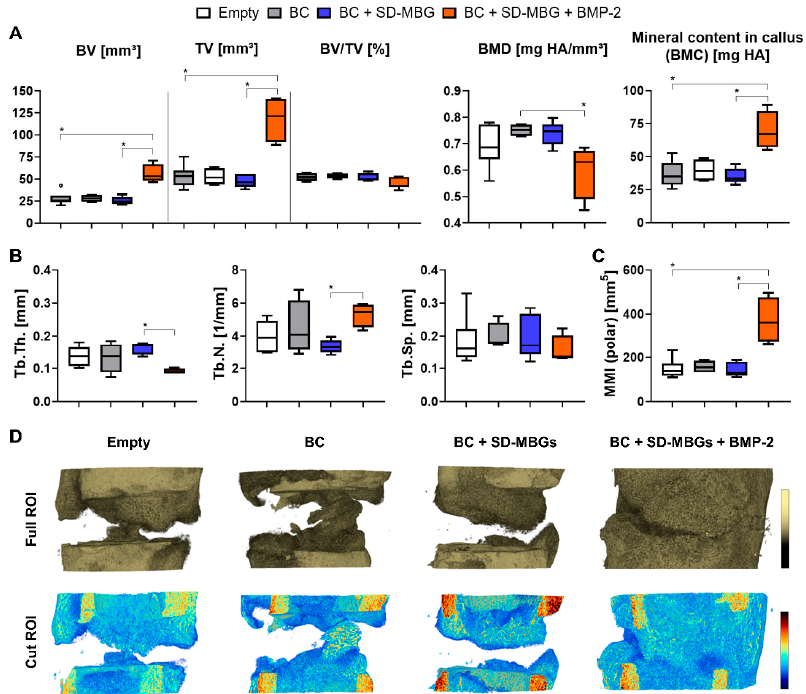
Figure 5. Ex vivo micro-computed X-ray tomography (µCT) analyses of the rat femora osteotomy gap area at four weeks post-surgery. ( A ) Bone volume (BV) and tissue volume (TV) were increased in the BMP-2 group while no difference was observed across all other groups. The ratio of BV and TV (BV/TV) remained unaffected. The bone mineral density (BMD) was reduced for the BMP-2 group, while the bone mineral content (BMC, BMC = TV × BMD) within the callus increased. ( B ) Microarchitecture of the bone in the osteotomy area was similar among all groups, except for the BMP-2 group, exhibiting a lower trabecular thickness (Tb.Th.) and higher trabecular number (Tb.N.) compared to the SD-MBG group, while trabecular separation (Tb.Sp.) was not changed. ( C ) Polar minimal moment of inertia (MMI (polar)) was significantly higher in the BMP-2 group, describing a more stable callus to torsional load, compared to all other groups. ( D ) Representative images of 3D rendered images of the osteotomy area. Top panel showing the entire volume of interest (VOI), bottom panel depicting density distributions of a longitudinally sectioned half of the VOI. The color scale indicates the mineralization state, which increases from blue to red. ( A – C ) n = 4–6 animals per group, shown are Tukey box plot distributions with line at median. A Kruskal-Wallis test with Dunn’s multiple comparison test was applied using the BMP-2 group as comparator. BC: blood clot. p -values for statistical significance were * p < 0.05.